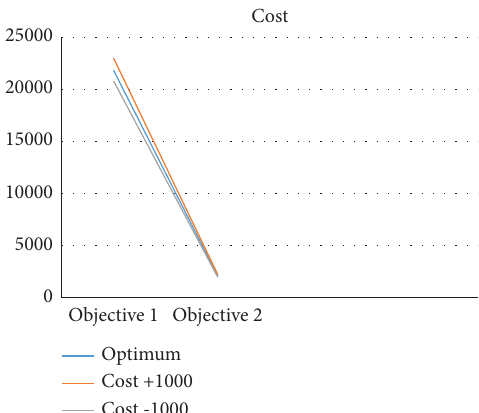
Figure 6: Cost changing effect on both